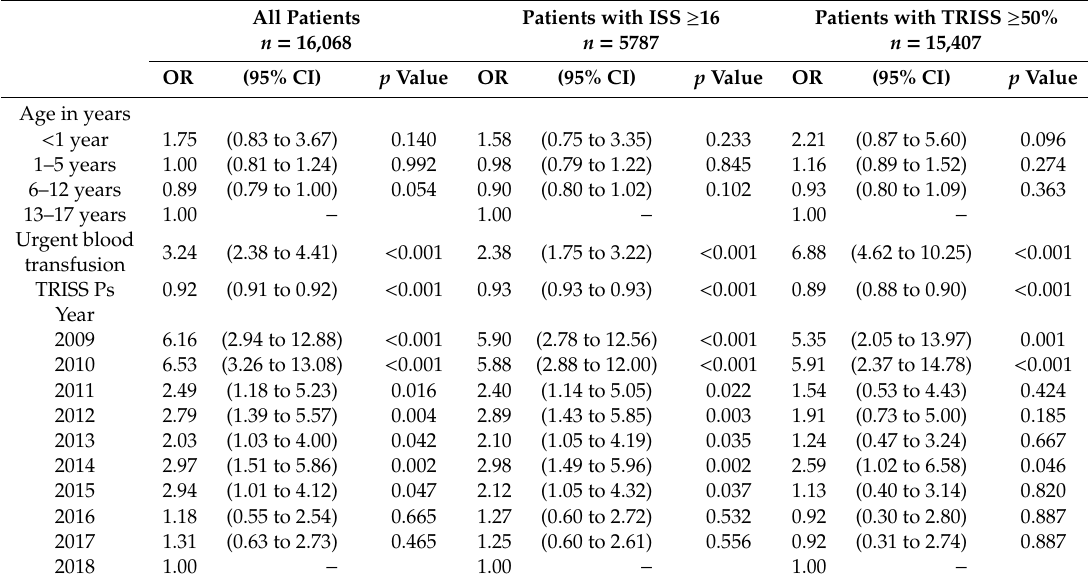
Multivariate logistic regression analysis of in-hospital mortality among paediatric injured patients.